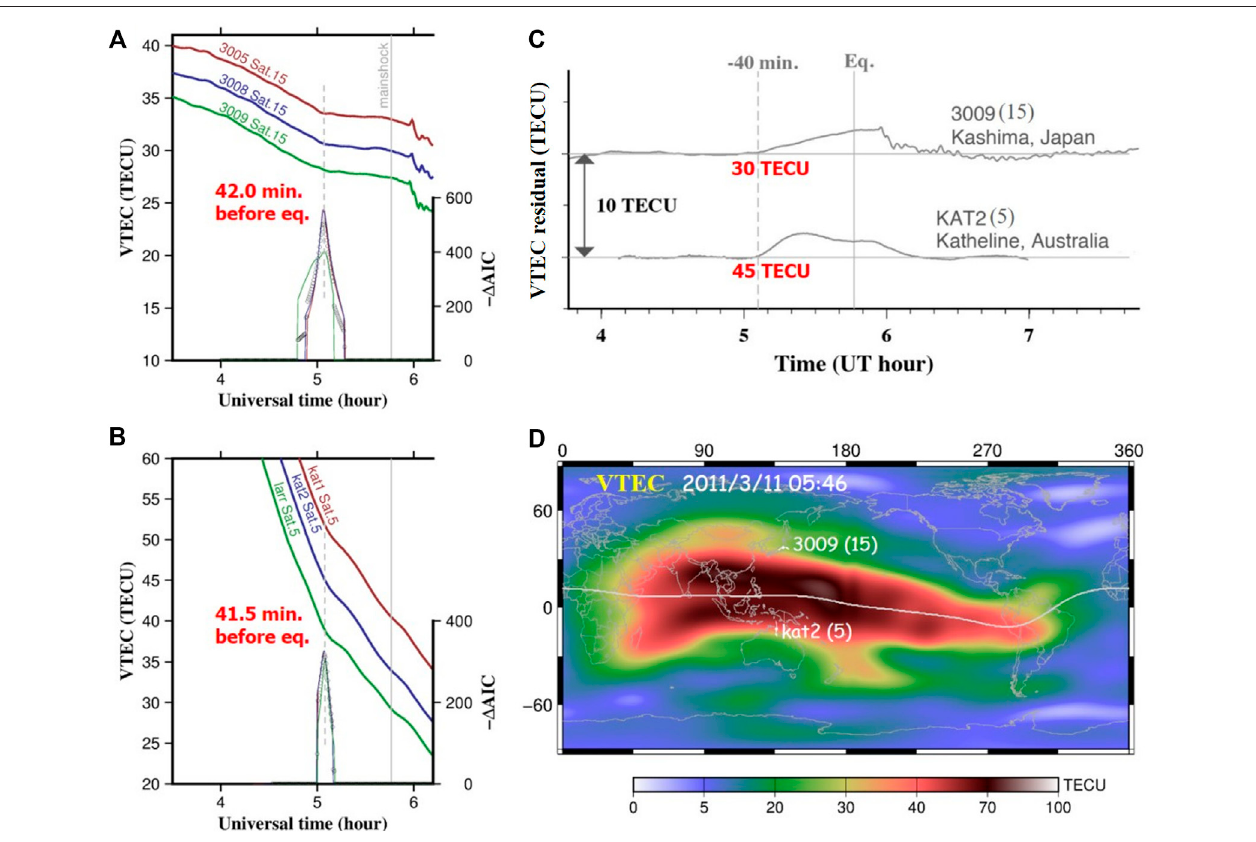
FIGURE4 | The onset times of the preseismic VTEC enhancementswereobserved (A) near the epicenter ofthe 2011 M w 9.0 Tohoku-oki earthquake and (B) near itsCPinAustralia,inferred usingAICfollowingHekiandEnomoto(2015).Thecoloredthickcurvesin (A) and (B) showtheselectedVTECtimeseriesbeforeandafterthe earthquake in Japan and in Australia, respectively (kat1 is very close to kat2). The vertical gray lines represent the earthquake occurrence time. In calculating the – Δ AIC (decreaseofAICbyassumingabreakatthemiddleofthemovingwindow),weusedthemovingtimewindowsof±30 min,andtheabsoluteandrelativethresholds of three TECU/h and 50%, respectively. The time window was shortened to ±20 min for the Australian data. The colored thin curves show the – Δ AIC time series (same colorsforsamestation-satellitepairs).Wecalculatedtheaveragesofthe – Δ AICchangesofthethreeGNSSstationsandfoundsigni fi cantpositivebreaks~40 minbefore the earthquake both in Japan and Australia. To compare the VTEC rate change, we plot the VTEC residuals from reference curves together with instantaneous VTEC values at the onset time of the anomalies in (C) (~30 and ~45 TECU for Japan and Australia, respectively). The global ionospheric map (from ftp.aiub.unibe.ch) in (D) shows the VTEC distribution at the earthquake occurrence time. The SIP trajectories same as in Figure 2 are plotted in (D) in white.